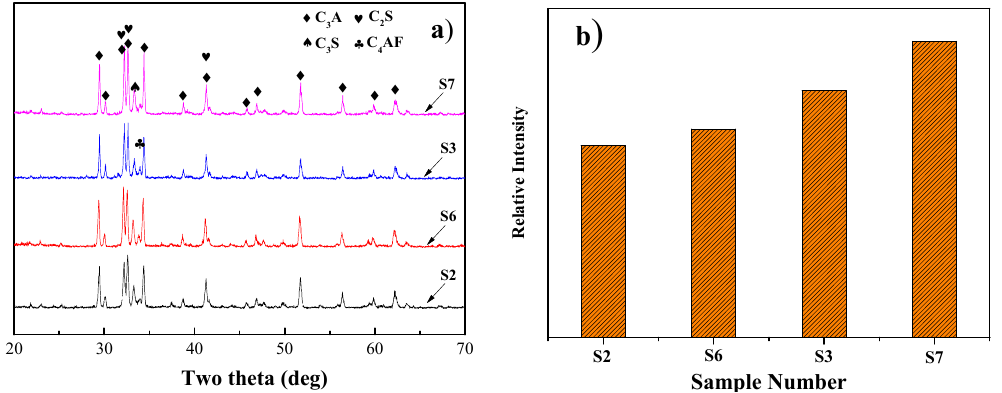
Figure 4. The comparison XRD patterns of the clinker adding with different amount of SS, CG and the peak intensity of C 3 S: ( a ) XRD patterns; and ( b ) comparison of XRD peak intensity at 2 θ from 31.8° to 32.4°.